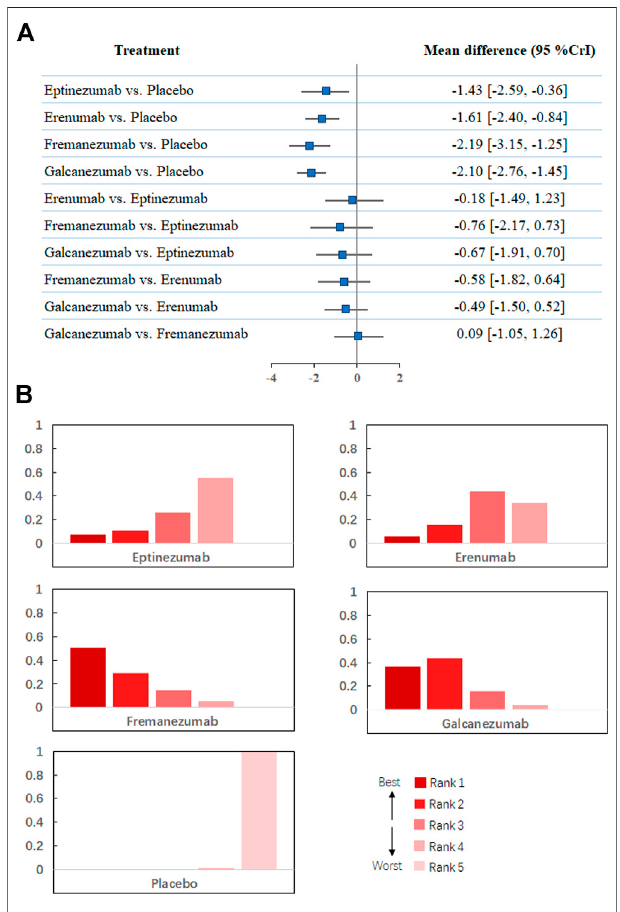
FIGURE 3 | (A) . Network meta-analysis of change in monthly migraine days. (B) . Ranking positions of different drugs in monthly migraine days. CrI: credible interval.